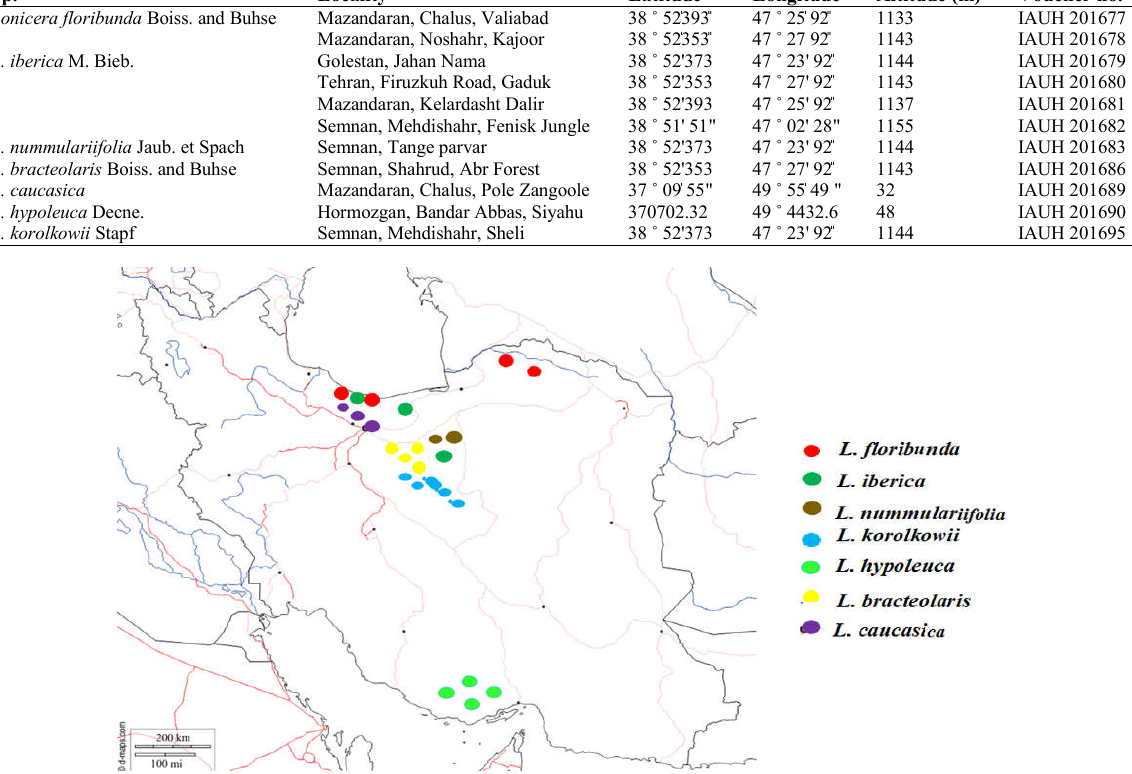
Table 1. Lonicera species and populations, their localities, and voucher numbers. Sp.